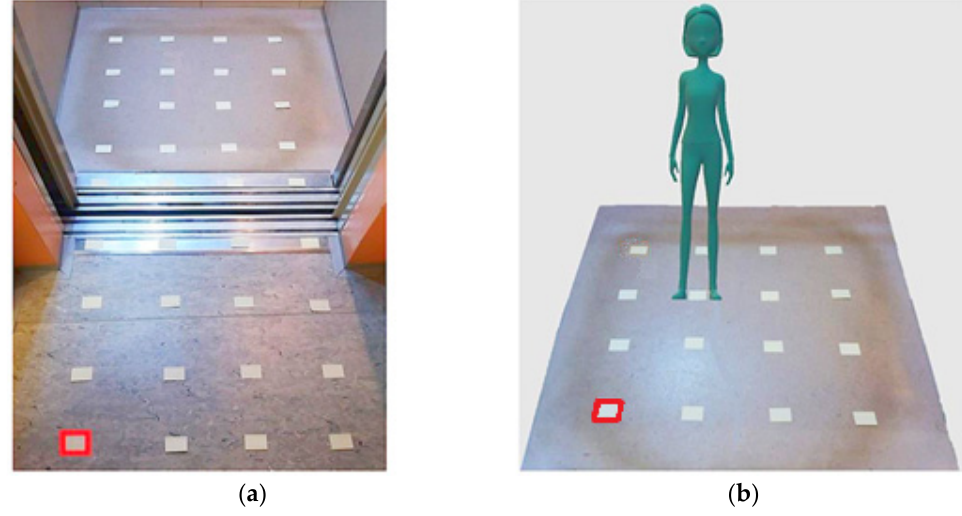
Figure 5. Measurement setup description: ( a ) representation of measurement points inside the empty elevator and in front of the elevator; ( b ) location of measurement points and position of the person on the phone in the elevator area.